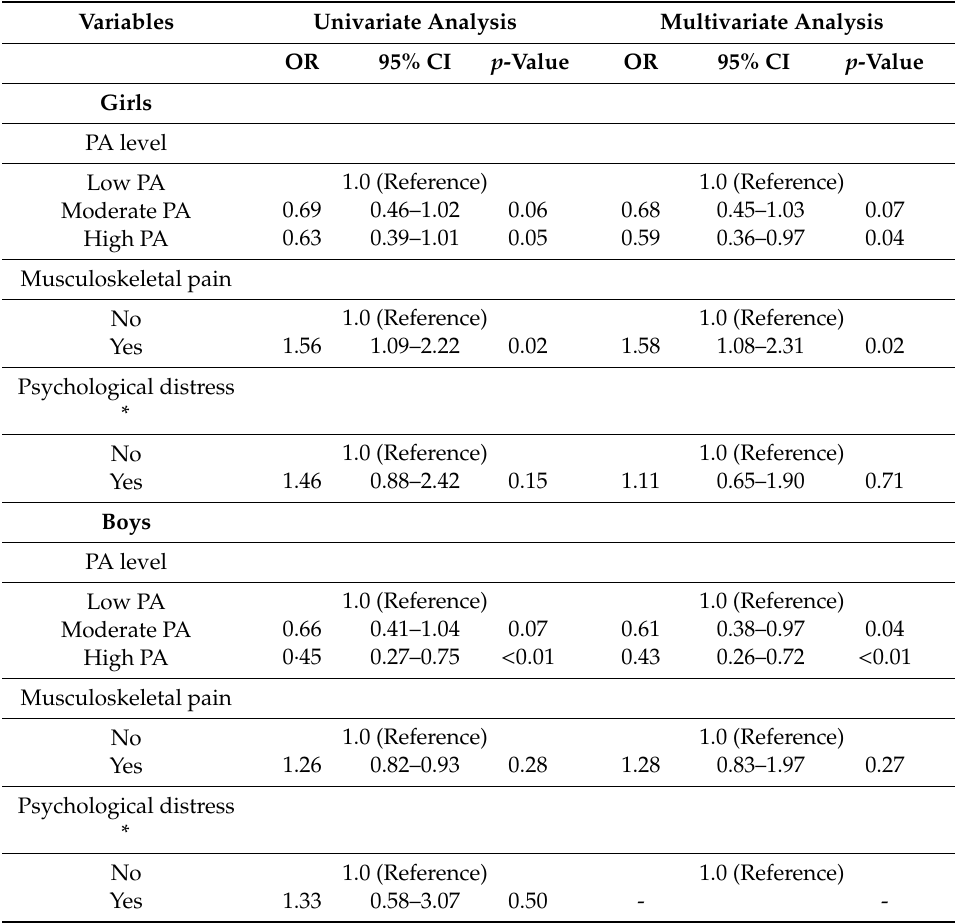
Table A1. Results from logistic regression analysis with obesity (BMI ≥ 30) as dependent variable, with the reference group restricted to individuals within normal weight (BMI 18.5–24.9 kg / m 2 ).